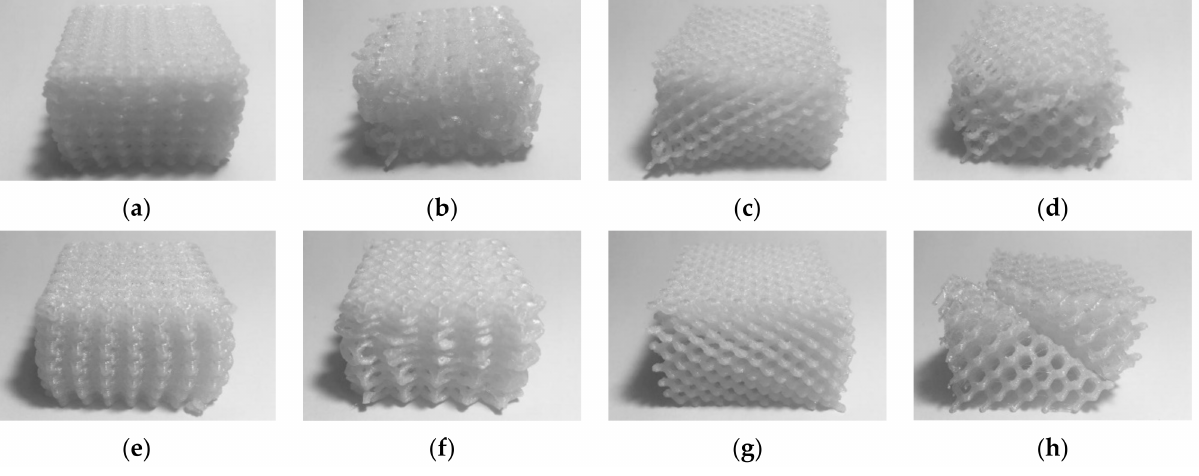
Figure 9. PC printed and tested samples ( a ) 009; ( b ) 010; ( c ) 011; ( d ) 012; ( e ) 013; ( f ) 014; ( g ) 015; and ( h )